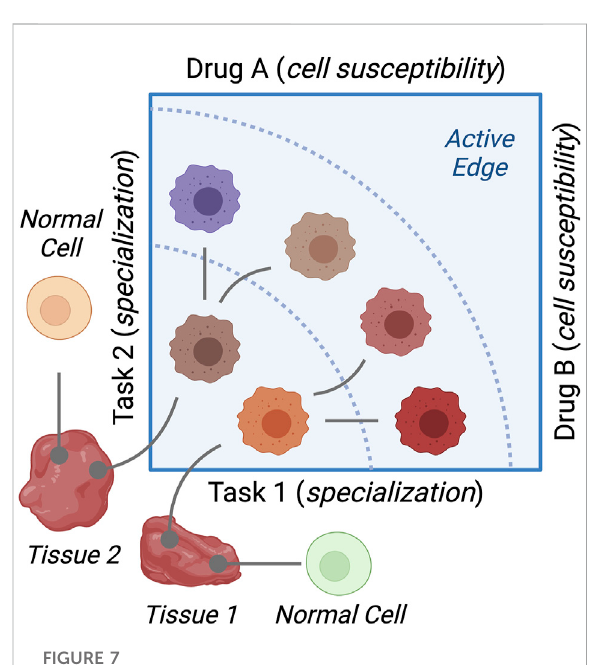
FIGURE 7 Diagram of the study fi ndings. Cancer cell lines represent variations of cancer cells growing in different tissues. Resources dedicated to speci fi c cellular functions differ between the cell types. This results in cancer cells specializing in functions (tasks) and making trade-offs to their advantage. Cells specialized in a given task are sensitive to drugs that disrupt this